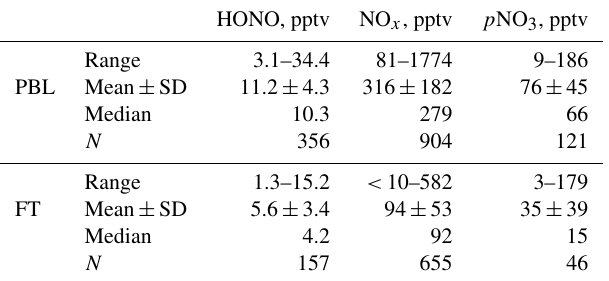
Table 2. Data statistics for HONO, NO x and p NO 3 measurements in both the PBL and the FT from the five southeastern US research flights during the NOMADSS 2013 summer field study. The statis- tics analysis is based on 1min NO x data, 3min HONO data and 6min p NO 3 data. HONO, pptv NO x , pptv p NO 3 , pptv Range